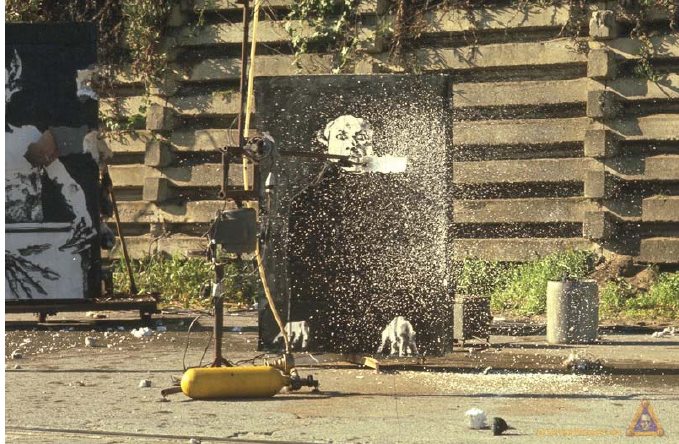
Figure 7. Scene from Mysteries of the Reactionary Mind , a mechanical performance by SRL, 5 April 1981, Fort Mason Center, San Francisco. © Survival Research Labs.